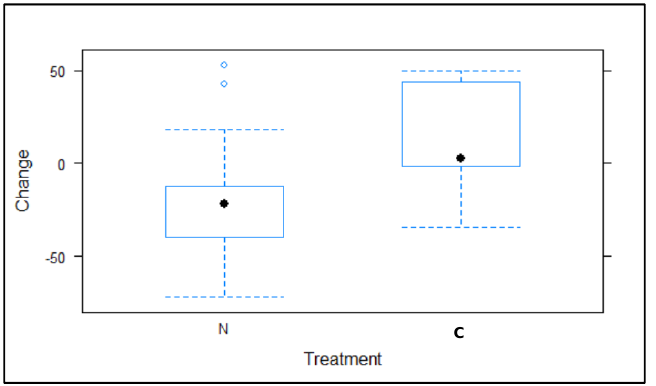
Figure 3. Percentage difference (change), between the 2017 pre-treatment and post-treatment periods, according to the treatment group, test (N, nicarbazin) and control (C)).